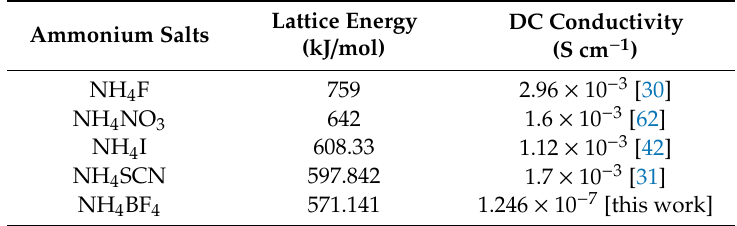
Table 4. Relation between DC ionic conductivity and lattice energy of di ff erent ammonium